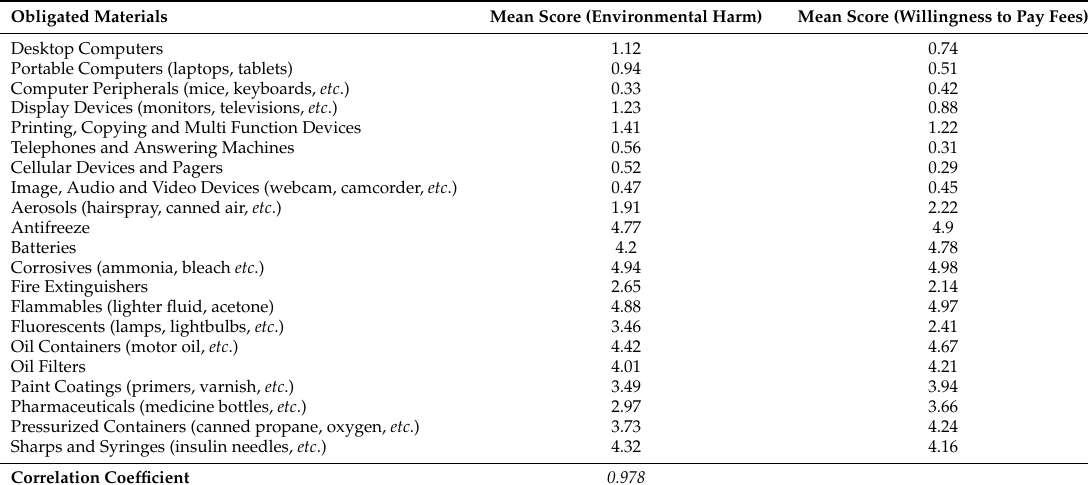
Table 6. Relationship between fees and perception of environmental harm.